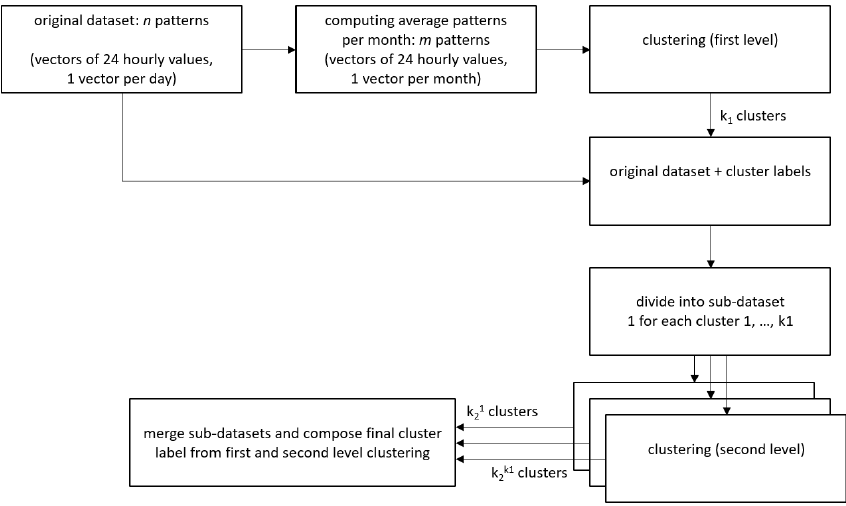
Figure 2. A schematic representation on the two-level clustering procedure that is the first stage of the proposed approach.